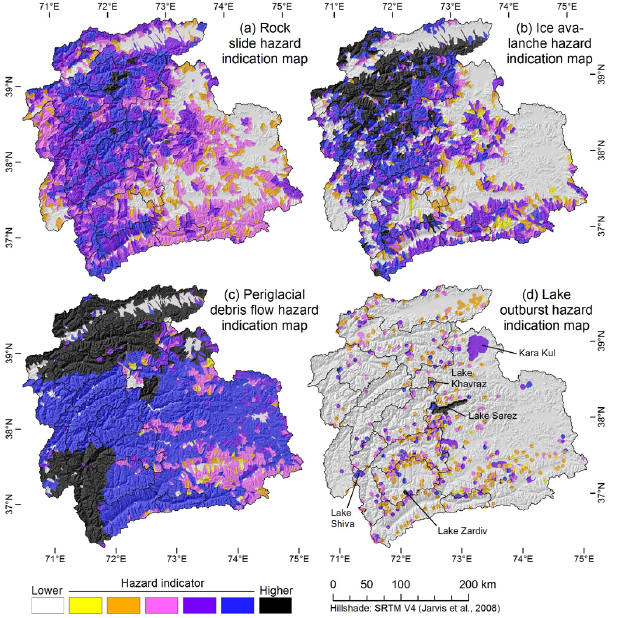
Fig. 8. Distribution of (a) rock slide, (b) ice avalanche, (c) periglacial debris flow and (d) lake outburst hazard indicators over the entire study area. The maximum indicator is shown for each catchment.